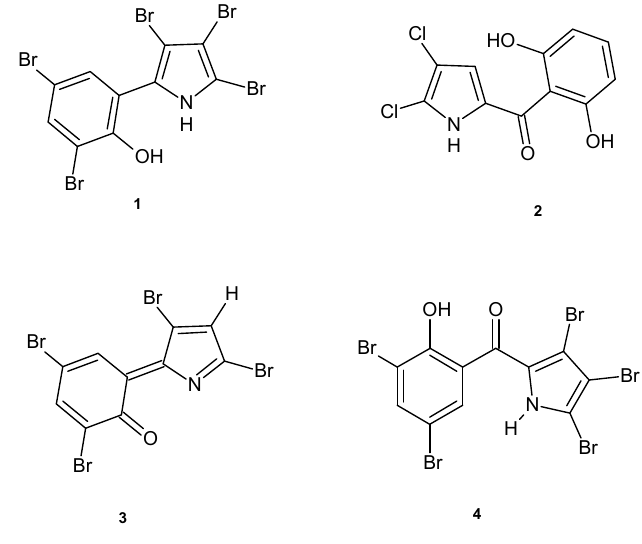
Figure 1. Structures of compounds 1 – 4 .